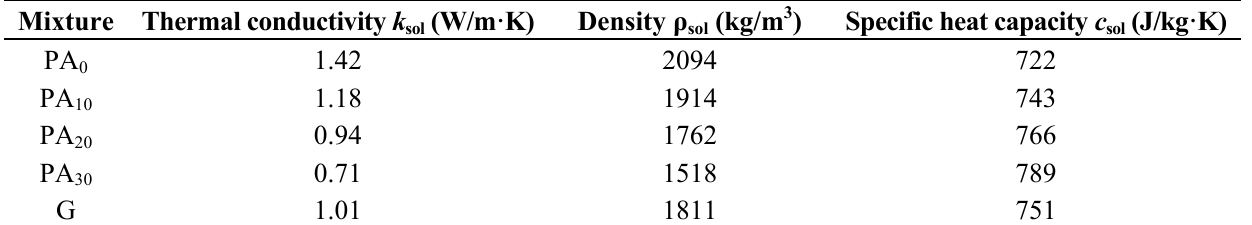
Table 6. Thermal properties for prepared materials.